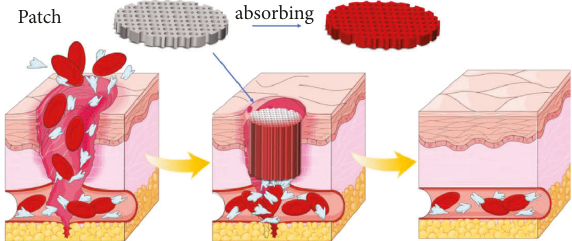
Figure 1: By attaching and covering the damaged tissue to close the wound, there is a certain pressure effect on the wound and form an effective physical barrier, and then use its internal pore structure to quickly absorb blood and water, activate platelets to accumulate quickly, and achieve the effect of hemostasis.